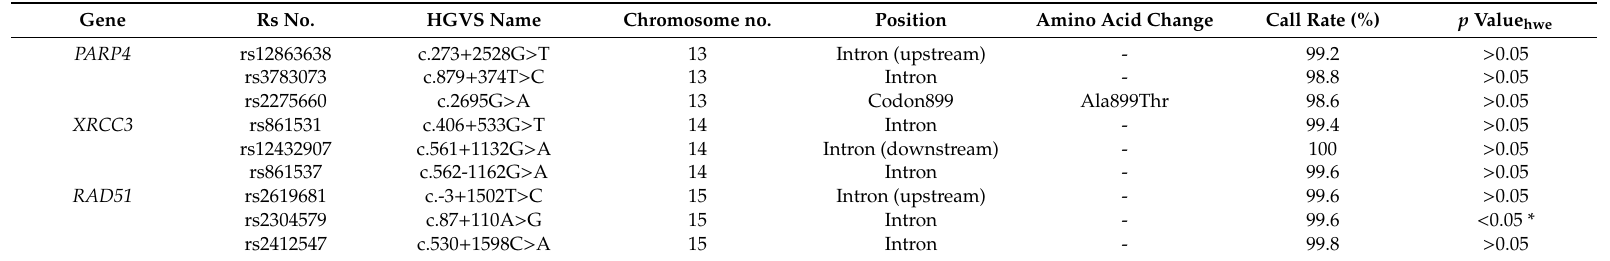
Table 3. Genotyped